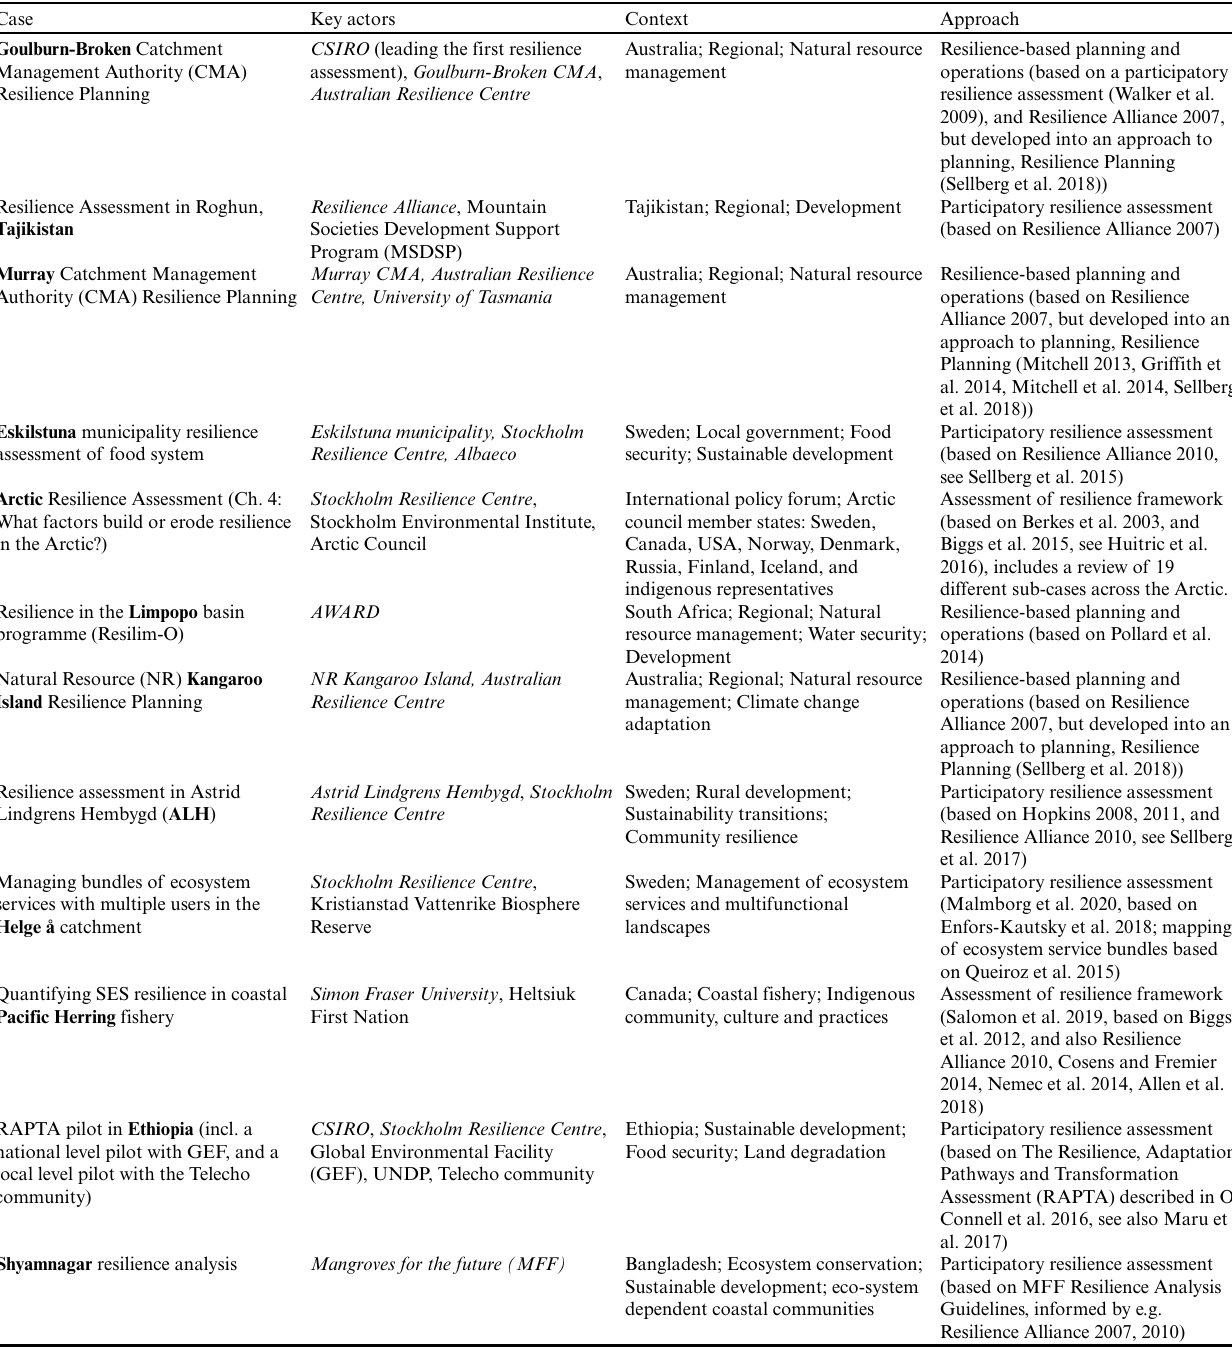
Table 2. Cases of resilience practice included in this study. The cases were initiated by different actors, academic or non-academic (see lead actors in italic), and were to varying extents co-designed by researchers and practitioners. Cases are referred to in the text using the bold part of the full case name. The order of appearance is based on when the case was initiated. The earliest case started in the beginning of the 2000s, but the majority of cases were initiated after